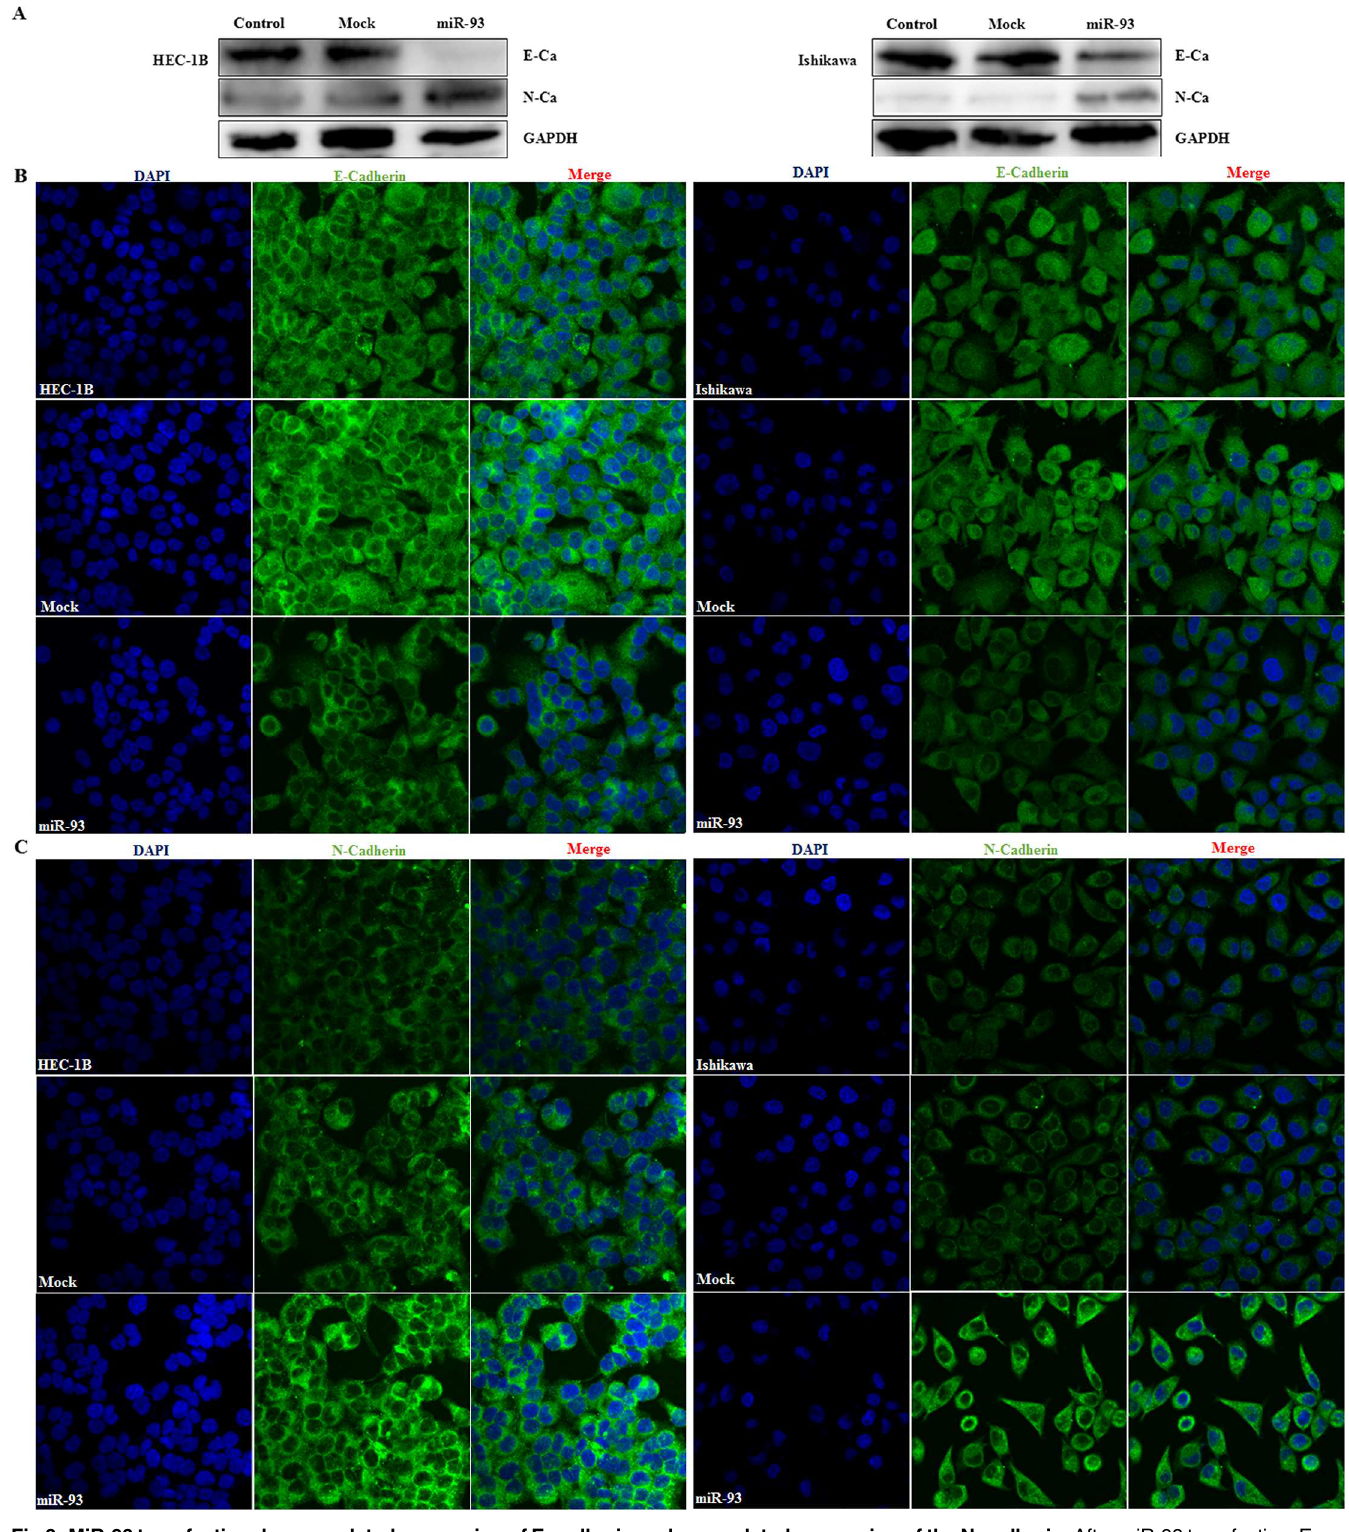
PLOS ONE | DOI:10.1371/journal.pone.0165776 November9,